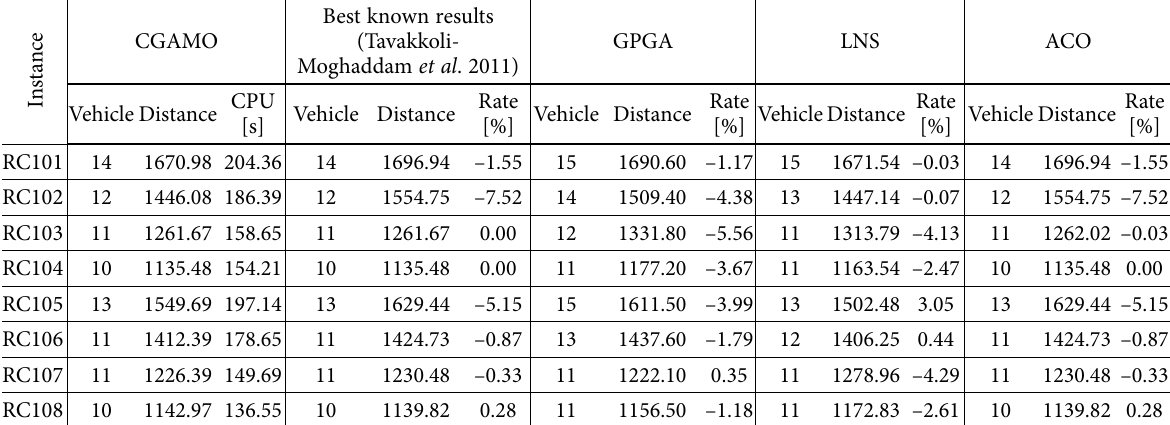
Table 4. Comparison results of different methods for VRPTW of RC1